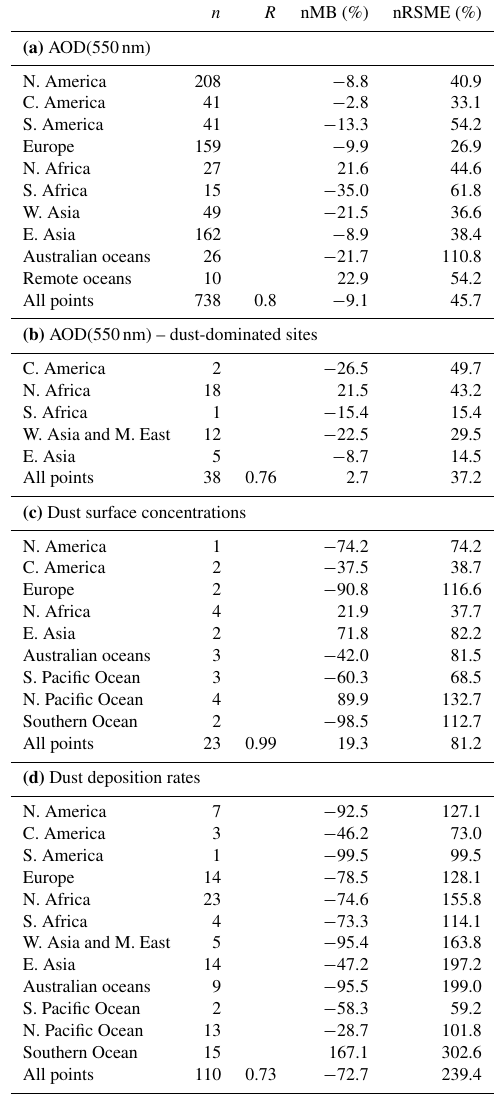
Table A1. Summary of statistics for all points and per region (as depicted in Fig. 1) for the evaluation of (a) the modeled annual mean AOD at 550nm against AERONET version 3 level 2.0 retrievals for all available stations covering the 2000–2014 period, (b) the same but for selected dust-dominated AERONET sites (characterized as described in Sect. 2.5), (c) the modeled annual mean dust surface concentration for 2000– 2014 compared to climatological mean values from RSMAS sites and AMMA campaign, and (d) the modeled annual dust deposition flux averaged for the period 2000–2014 against observations as compiled in Albani et al. (2014) from several sources. The number of stations ( n ), the Pearson correlation coefficients ( R ) between the simulated and measured monthly mean concentrations, the normalized mean bias (nMB), and the normalized root-mean-square errors (nRMSEs) are indicated for the EC-Earth simulation. n R nMB (%) nRSME (%) (a) AOD(550nm) N.